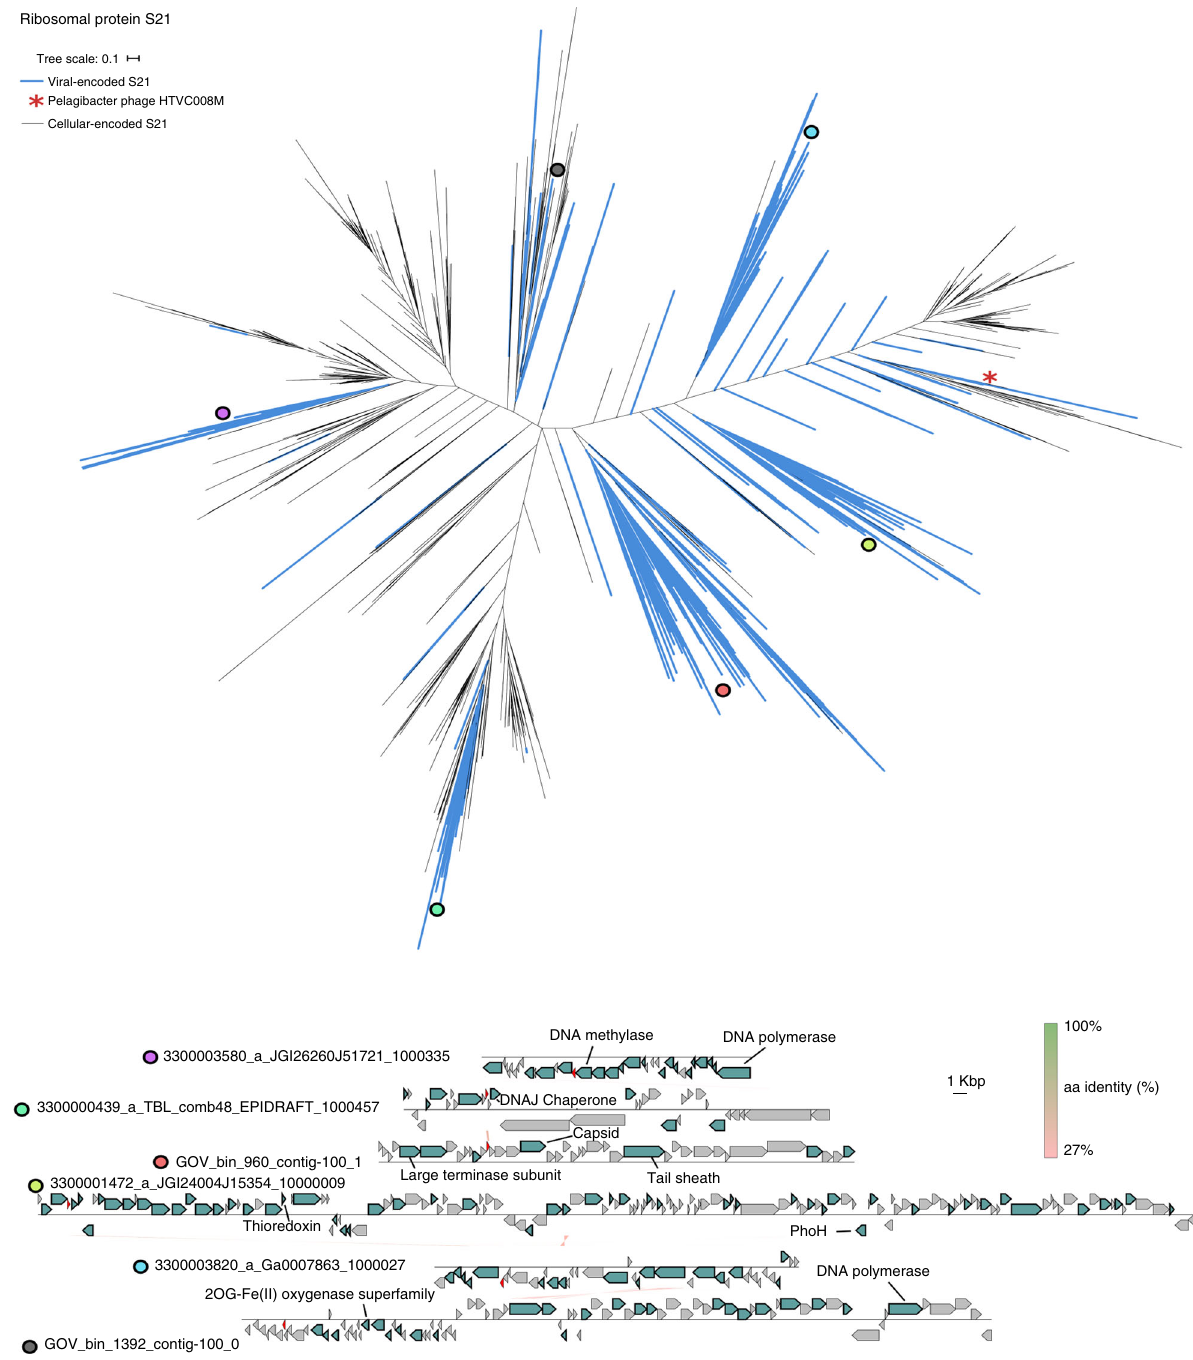
Fig. 3 Ribosomal proteins bS21 identi fi ed in uncultivated viral genomes. Top: Phylogenetic tree of ribosomal protein bS21. Viral sequences are highlighted with blue branches. Bottom: Genome comparison of viral contigs encoding ribosomal protein bS21. Comparisons were done at the amino acid level, with the % identity displayed with a color scale. The predicted bS21-encoding genes are indicated in red. The position of these sequences in the tree (top panel) is indicated with colored